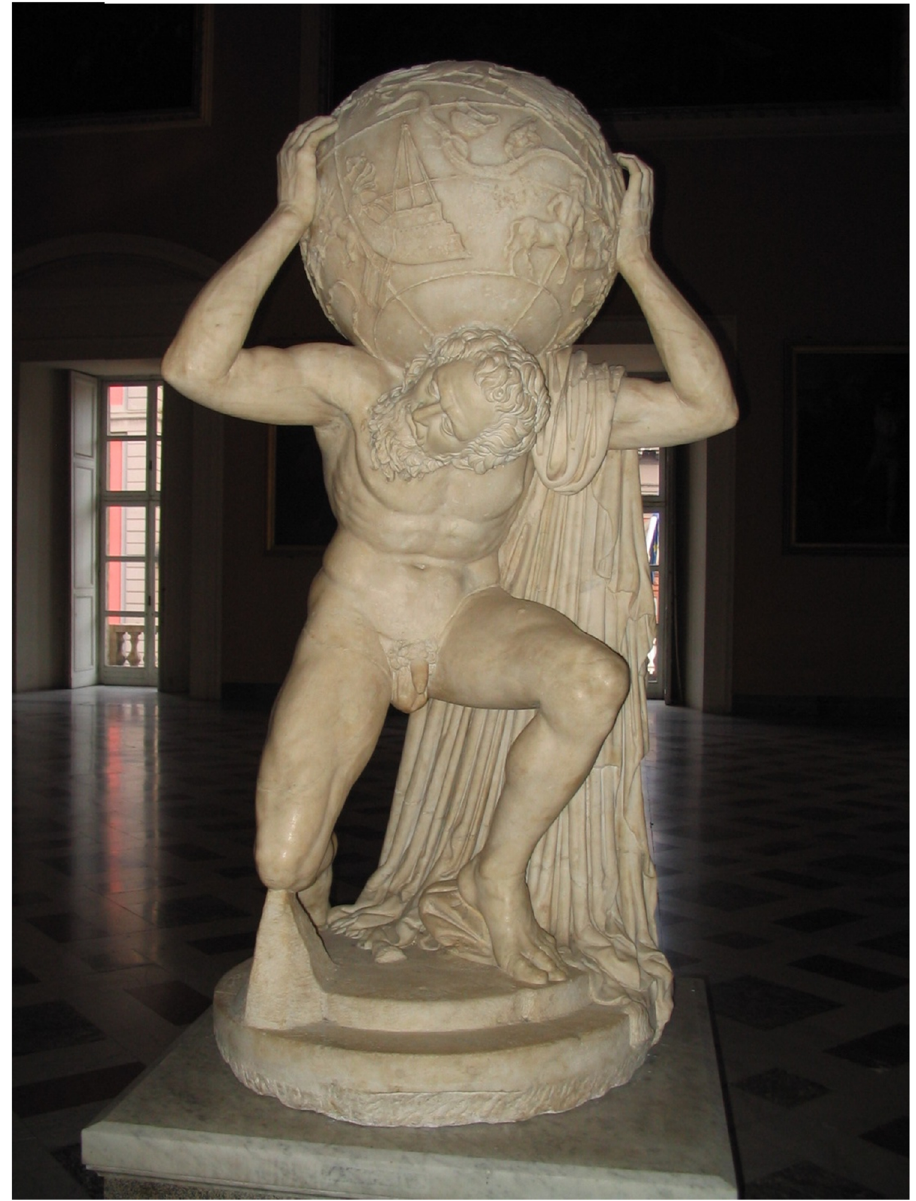
Figure 3: Farnese Atlas. Roman marble sculpture, second century AD, National Archaeological Museum, Naples. Source: Wikimedia